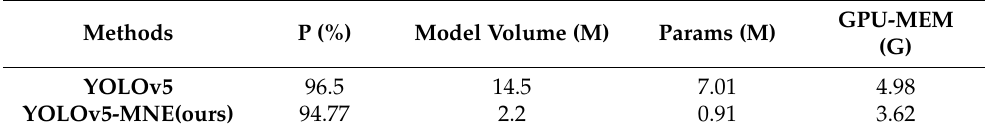
Table 3. Performance comparison with the raw YOLOv5 on the SSDD dataset.